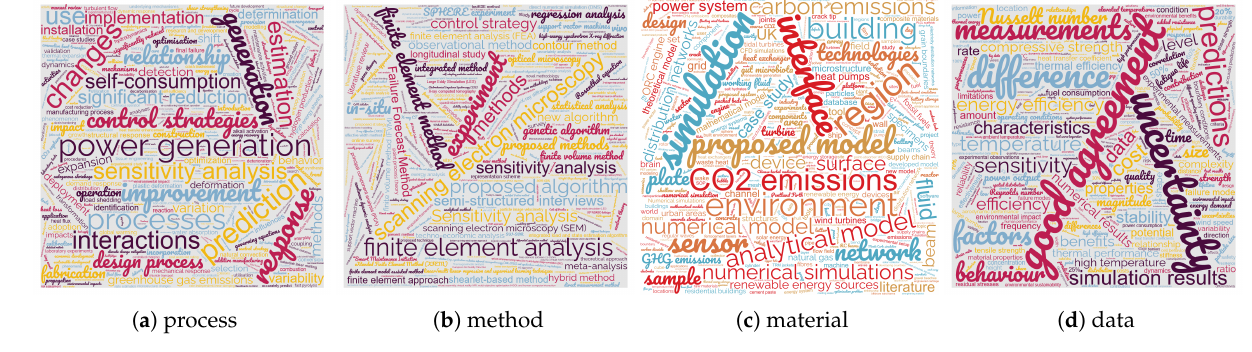
Figure 7. Engineering domain word clouds.